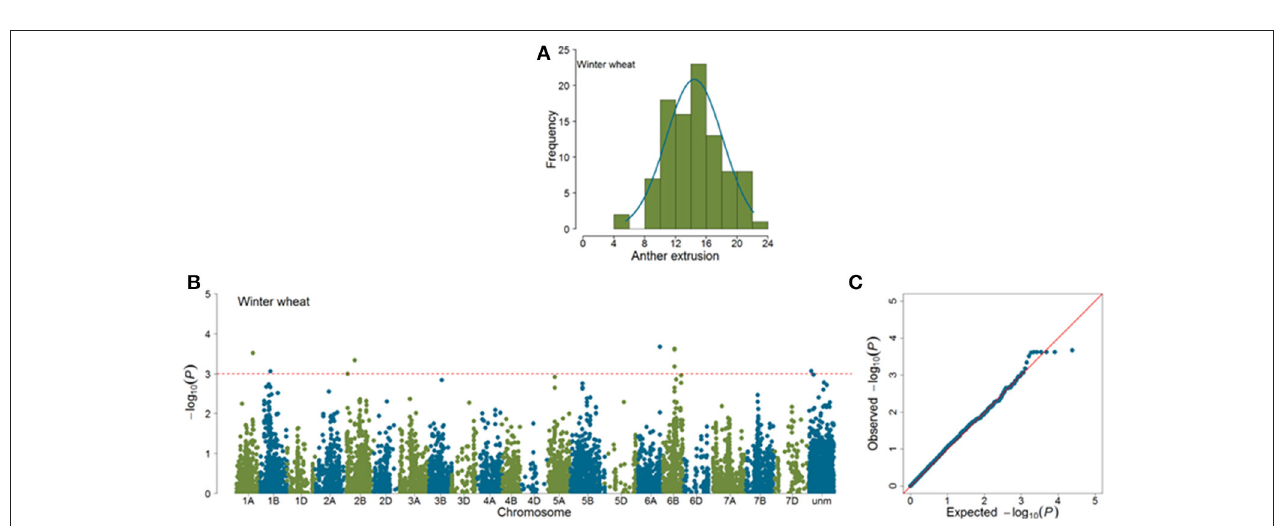
FIGURE 5 | Summary of genome-wide association studies results for anther extrusion (AE) in winter wheat panel (WP). (A) Distribution of Best Linear Unbiased Estimates of AE (B) Manhattan plots based on mixed linear model using kinship matrix ( K ) to correct for population stratification. Horizontal dashed line corresponds to the threshold ( | log 10 ( P ) | > 3.0) for MTA estimation. (C) Quantile-quantile plots depicting expected vs. observed | log 10 ( P ) |